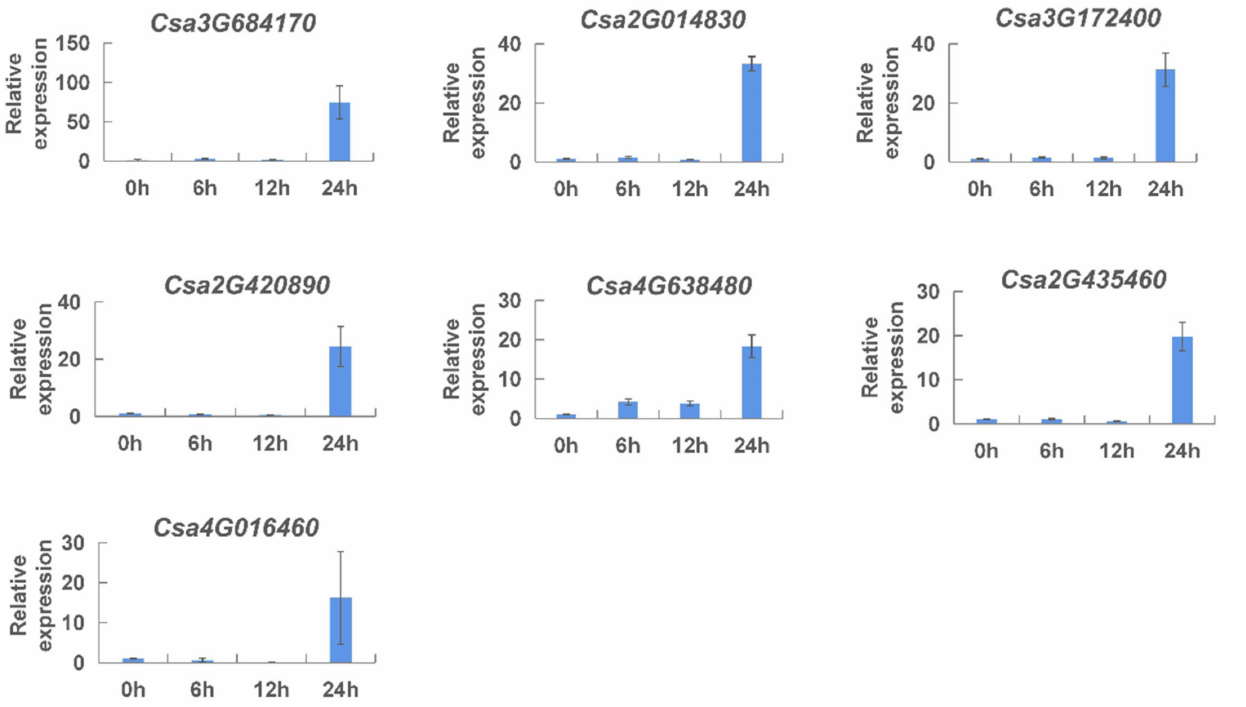
Figure 11. Expression analysis of the CNL genes responding to methyl jasmonate in cucumber plants. The vertical axis is relative expression level and 0, 6, 12, 24 h on the x -axis indicate the treatment time. The expression level of transcript at 0 h was set to a value of ‘1’. Values are mean ± SE (n =